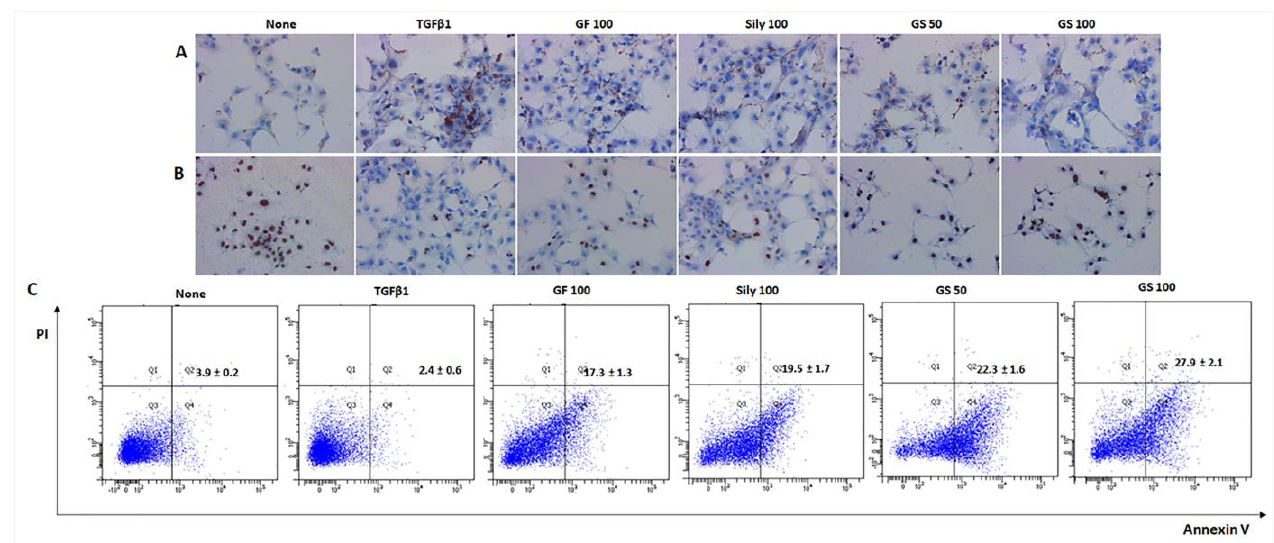
Figure 7. Selective effects of Sirt6 by induction of HSCs during fibrosis development. Representative images of IHC against ( A ) ColT1, ( B ) Sirt6. ( C ) Flow cytometry analysis. For HSCs’ activation, TGF- β 1 (5 ng/mL) was treated after 6 h of drug treatments. Data were expressed by mean ± S.E.M. ( n = 3 for IHC analysis, n = 4 for flow